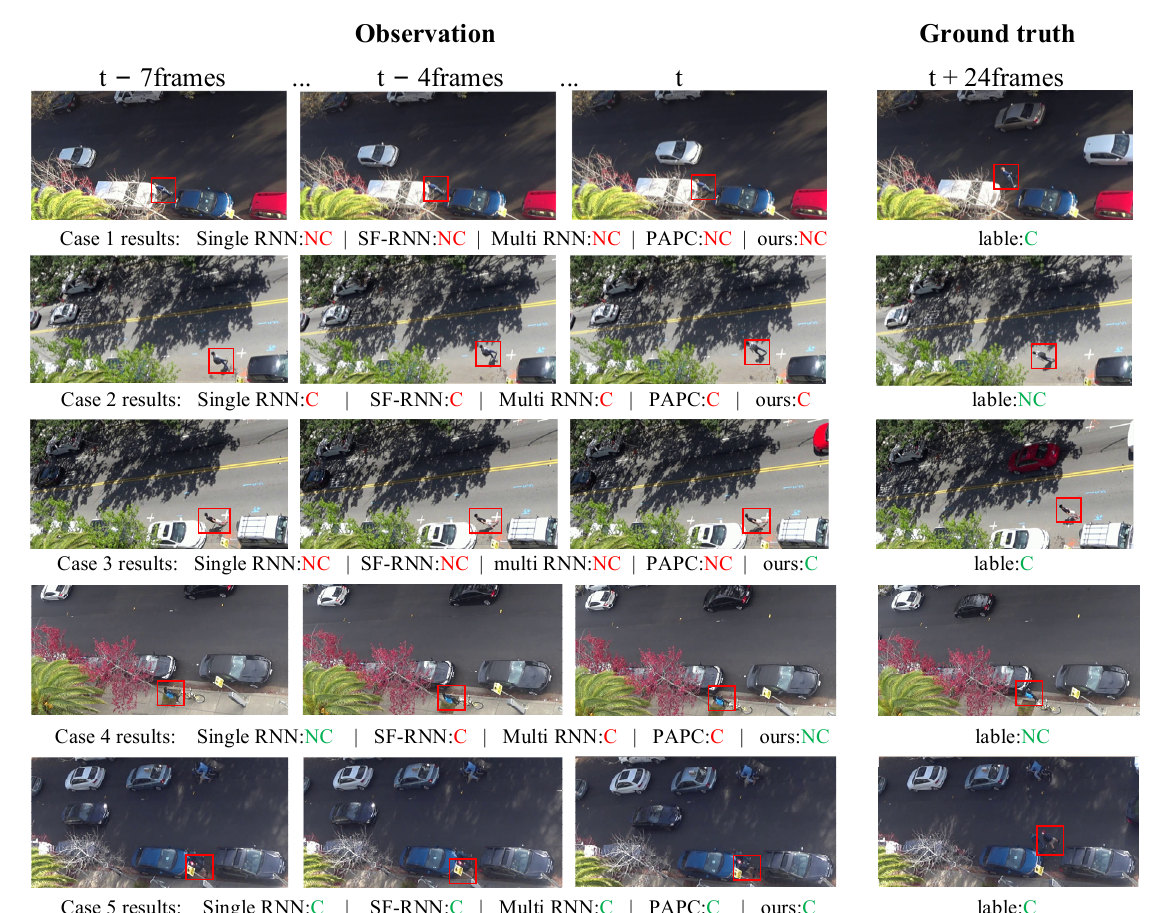
Figure 14. Examples of qualitative experimental results of pedestrian crossing behavior prediction. In each group of experiments, the left three pictures represent the observation frames of frames 1, 4 and 8, respectively, and the rightmost picture represents the real picture at the predicted time point. Where, C represents crossing the street, NC represents not crossing the street, red indicates wrong prediction, and green indicates correct prediction.